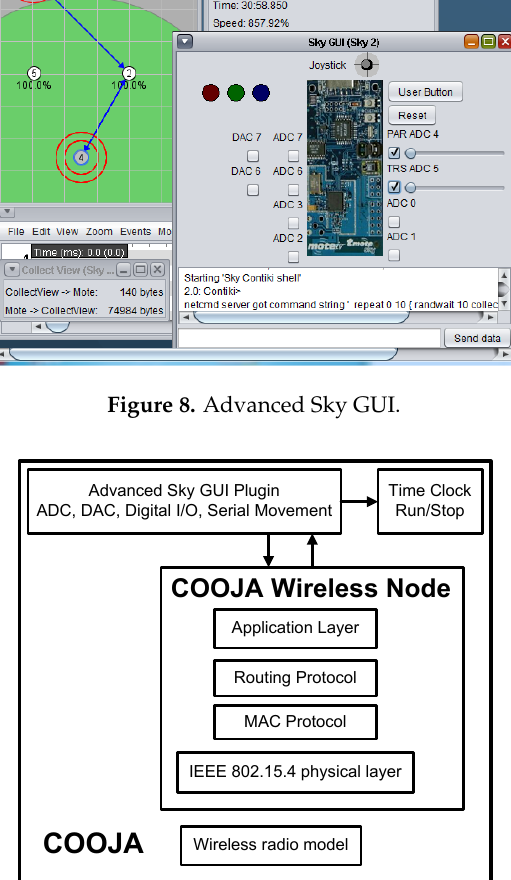
Figure 9. Advanced Sky GUI